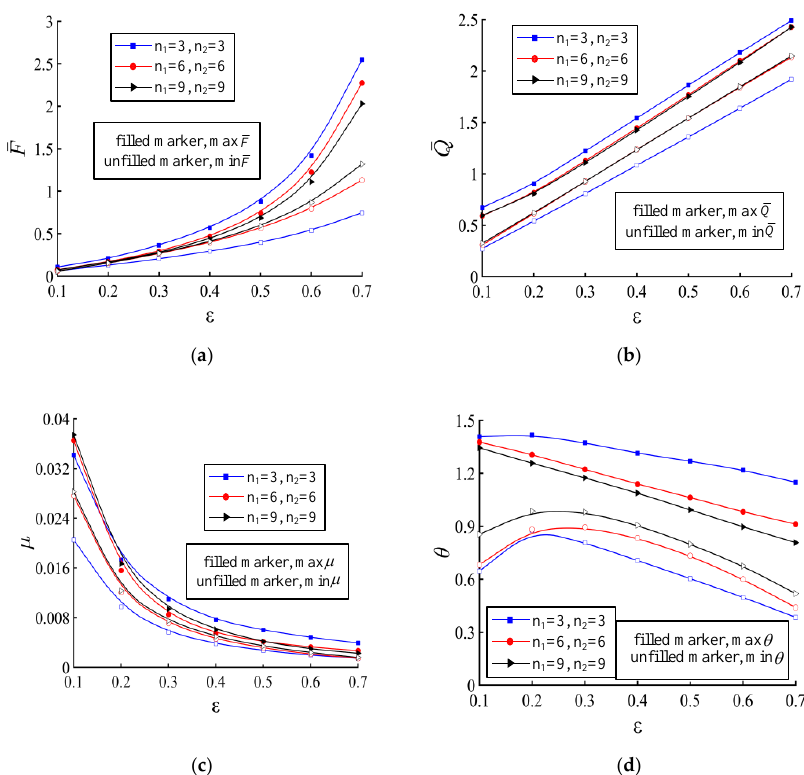
Figure 12. Variations of maximum and minimum dimensionless bearing load capacity ( a ), dimensionless end leakage flow rate ( b ), friction coefficient ( c ) and altitude angle ( d ) with the eccentricity ratio under the same waviness amplitude ratio ( A 1 = 0.05, A 2 = 0.1) and different waviness